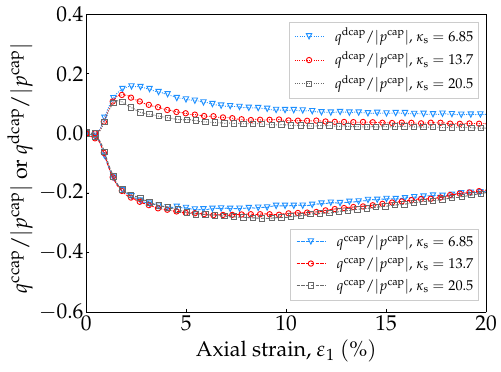
Figure 3. The e ff ect of κ s on the evolution of deviatoric behavior of the capillary stress during DEM triaxial tests.